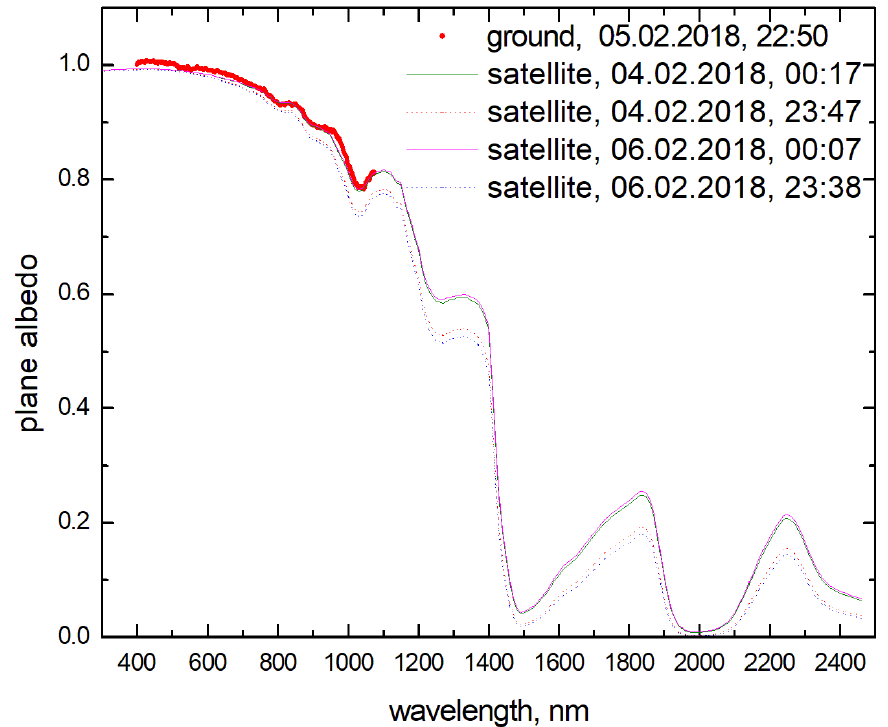
Figure 4. The intercomparison of plane albedo derived from ground measurements on 5 February 2018 and satellite measurements on 4 and 6 February 2018.